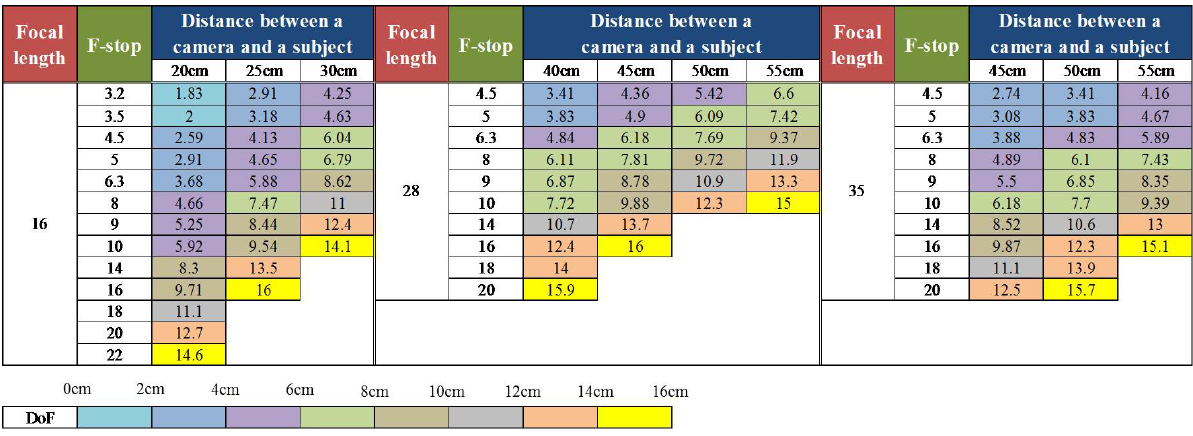
Figure 19. The ranges of the distance between the camera and the subject, focal length, F-stop and DoF.